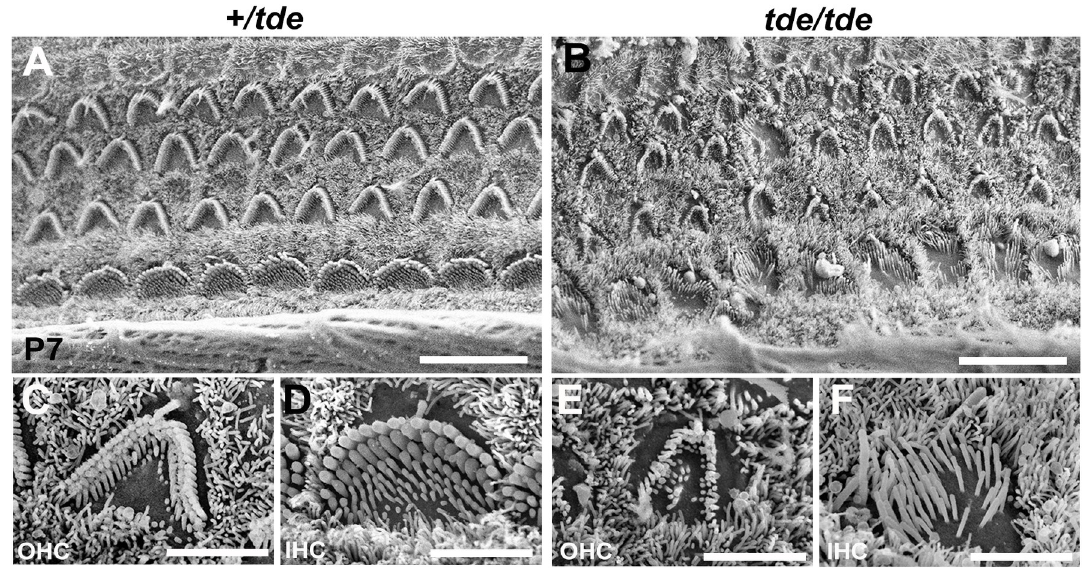
Fig 1. Analysis of cochlear hair cells and their stereocilia. A-F, SEM images of the organ of Corti at 50% distance from the base of the cochlea at P7. The typical arrangement of three rows of outer hair cells (OHC) and one row of inner hair cells (IHC) is observed in +/ tde ( A, C, D ) and tde/tde mice ( B, E, F ). The stereocilia in mutants ( B, E, F ) look severely disorganized, abnormally thin with floppy appearance compared to controls ( A, C, D ). Scale bars: ( A, B ) 10 μ m; ( C, D, E, F ) 3 μ